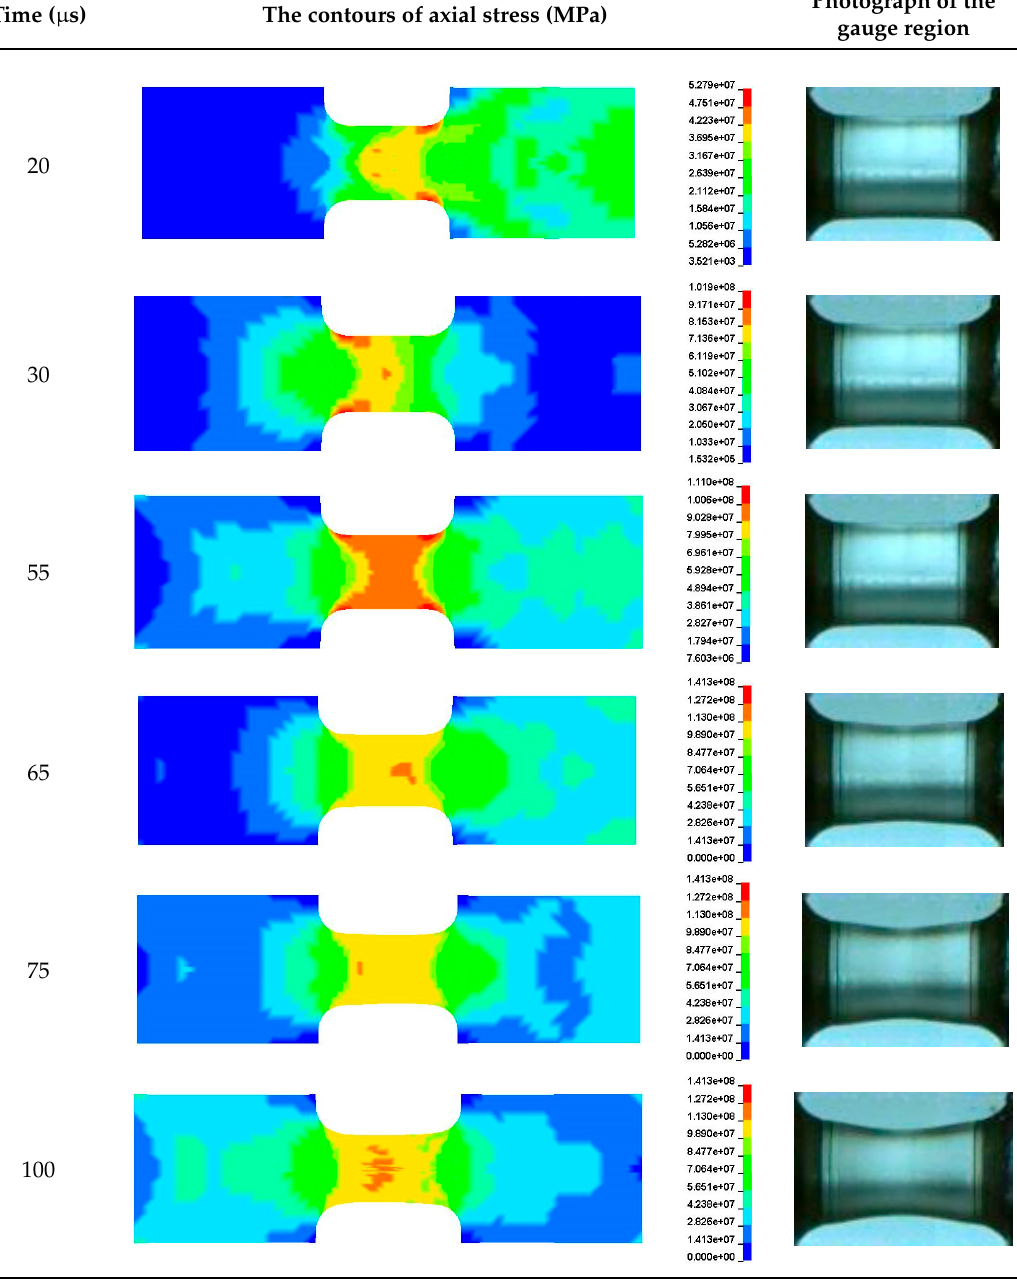
Table 1. Numerical results and the high-speed photographs during the test at strain rate of 4500 s − 1 . Time ( µ s) The contours of axial stress (MPa)